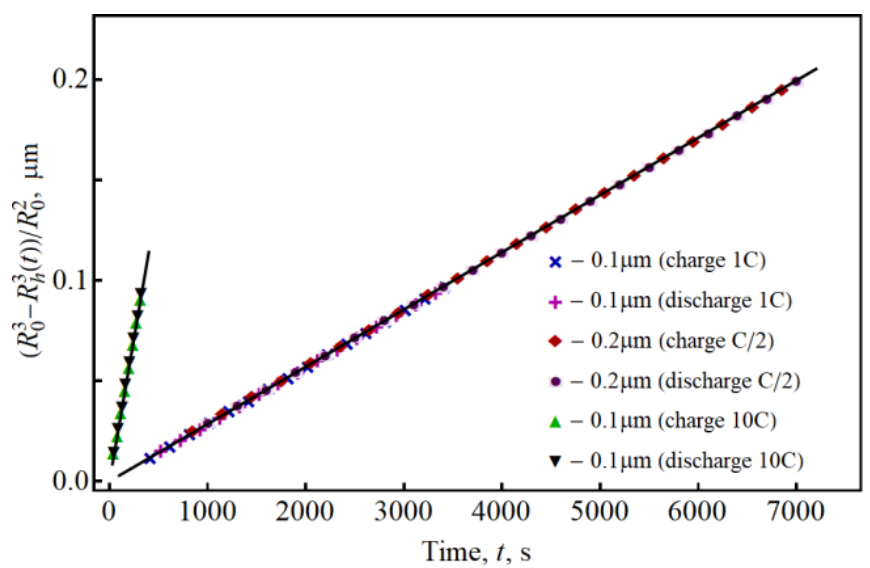
Figure 4. Kinetics of concentration wave propagation obtained by the CH Equation (points). Lines represent the linearized dependence (4). Size of particles and applied C-rate are indicated in Figure 2.